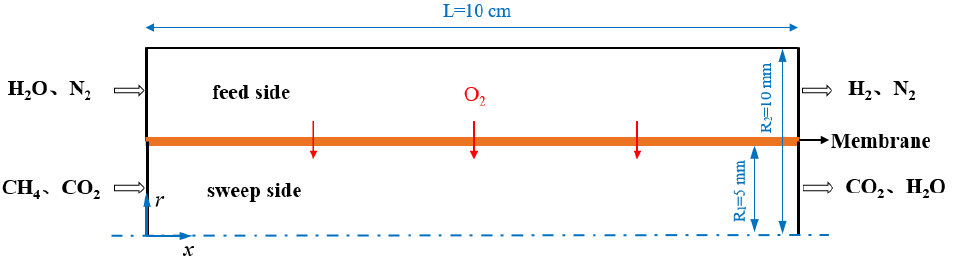
Figure 1. Schematic diagram of 2D axisymmetric representation of the coupled membrane reactor.